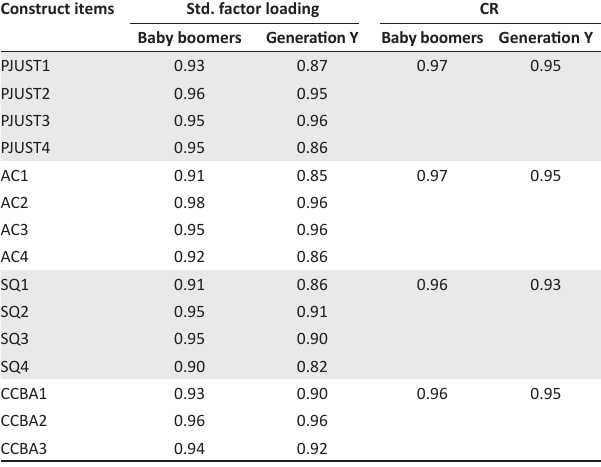
TABLE 2: Assessment of latent variables. Construct items